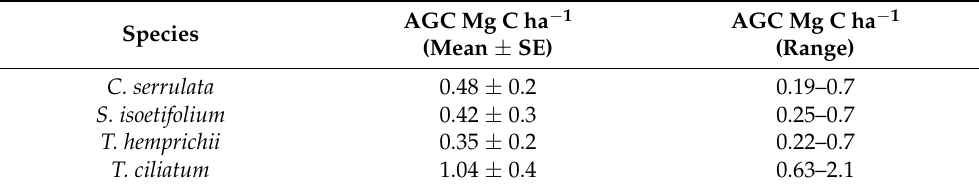
Table 5. Above ground carbon of dominant seagrass species in subtidal